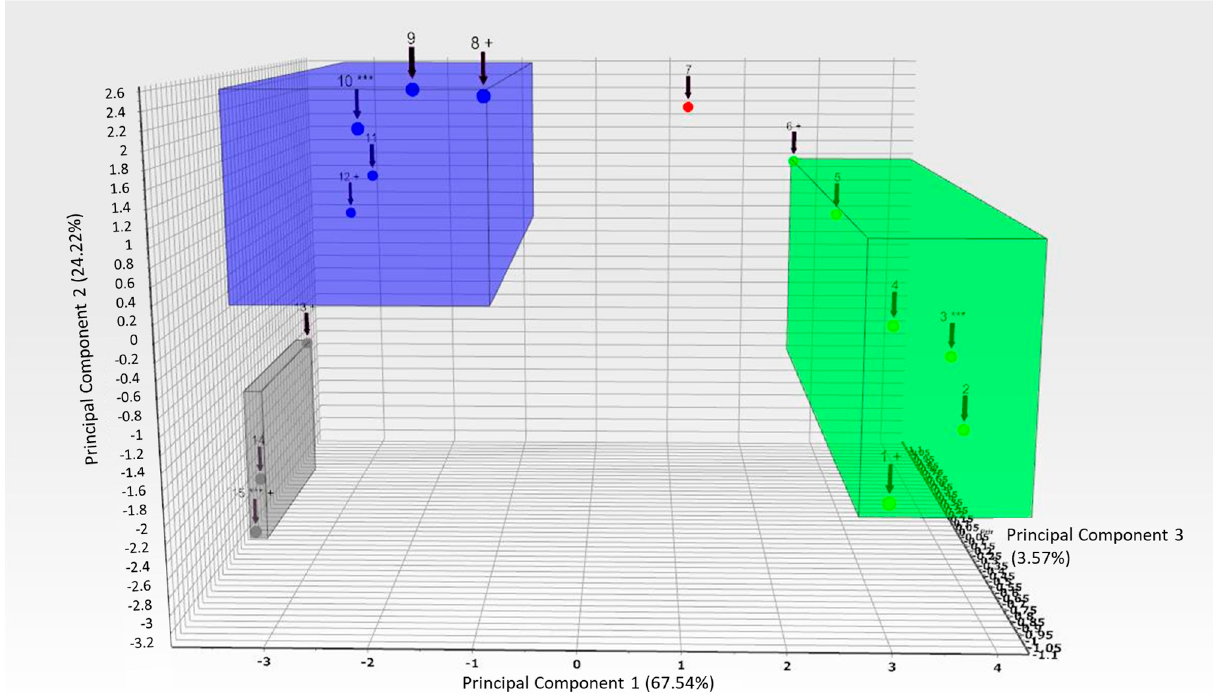
Figure 10. Clustering of spodumene–quartz mixtures (three clusters with different lithium contents). *** most representative sample of cluster, + are the most different ones in the clusters.